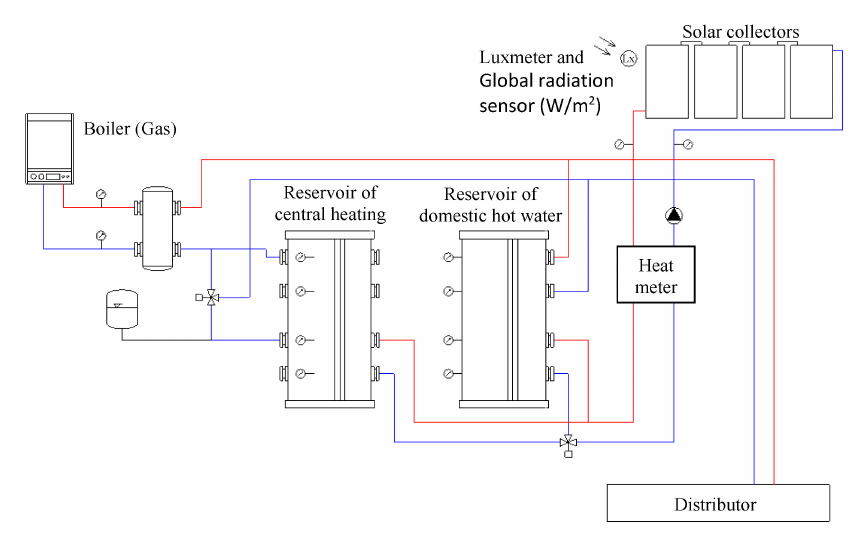
Figure 1. Scheme of a part of a multivalent laboratory system used in solar heating experiments. (The blue line represents the flow of the return heat medium in the system. The red line represents the flow of the heated heat medium in the system.).